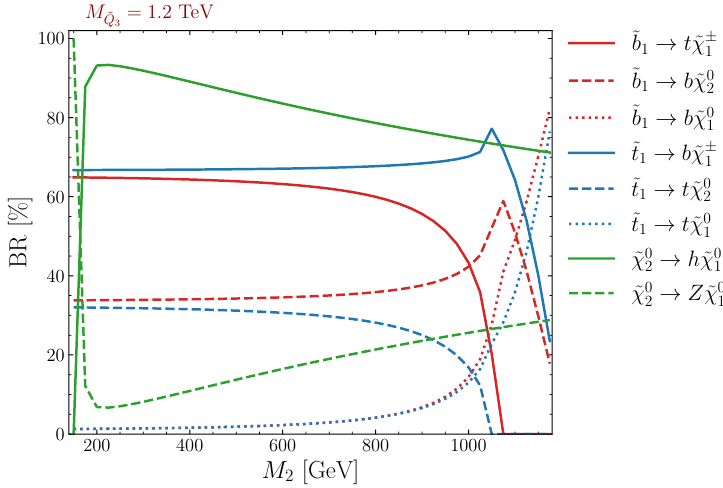
Figure 10: The decay branching ratios in the T6MSSM benchmark scenario as a = 1200 GeV and M function of M , for M ˜ 2 Q 3 is always